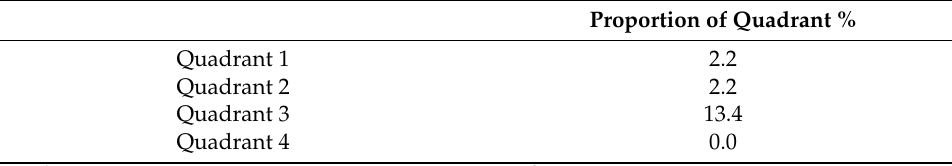
Table 8. I 3 classification and proportion of respondents that currently trap possums 1